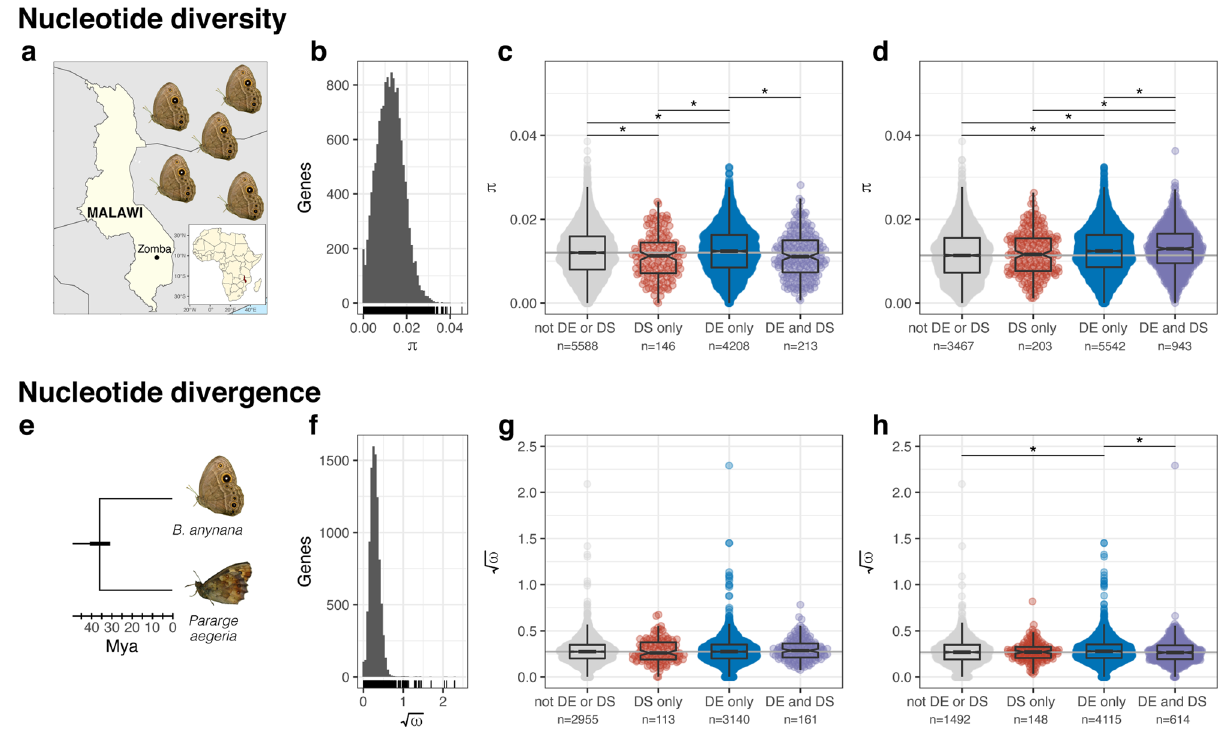
Fig. 3 Short term but not long-term constraint depends on molecular mechanisms of plasticity. a Five butter fl ies were collected from Zomba, Malawi, and used for population genomics. b Nucleotide diversity ( π ) was calculated for 14,402 genes in the B. anynana annotation, 10155 of which were multiexon. A histogram represents the distribution of π values, while a rug plot show values for individual genes. c Seasonally differentially spliced (DS, differential exon expression) genes had reduced π , whether the genes were also differentially expressed (DS only = red, DE and DS = purple). d In contrast, genes that were DS or DE among families tended to have increased π relative to the rest of the genome. e Nucleotide divergence ( ω ) was calculated between B. anynana and Pararge aegeria , which shared a common ancestor 31 – 41 mya 49 . f ω was calculated for 9306 single-copy orthologs, 6369 of which were multiexon, and square-root-transformed for analyses. g There was no difference in ω among genes that were differentially expressed or differentially spliced by season. h Among families, DE-only genes showed higher ω , although this pattern was inconsistent across tissues. c , d , g , h Data shown are based on abdomen samples (see Supplementary Fig. 7, 9 and Supplementary Table 5, 6 for fi gures and analyses based on thorax samples). Asterisks (*) denote statistically meaningful differences (Bayesian linear models, Supplementary Fig. 7A, C and Supplementary Fig. 9A, C). Point clouds represent π or ffiffiffiffi p ω values for each gene set. Values are summarized with boxplots: the center line represents the median, the box encloses the 25 th -75 th quartiles and is ffiffiffi p notched (median + / − 1.58 * interquartile/ n ), and whiskers extend to 1.5x the interquartile range. The grey horizontal line indicates the median of genes that were not DE or DS. Source data are provided as a Source Data fi le. Maps were constructed in R 100,101 and modi fi ed for publication with Inkscape 102 . B. anynana photo was modi fi ed with permission from O. Brattström. P. aegeria photo was modi fi ed with permission from O. Lindestad. Phylogeny schematic was made by the authors from data published in Pena et al. 56